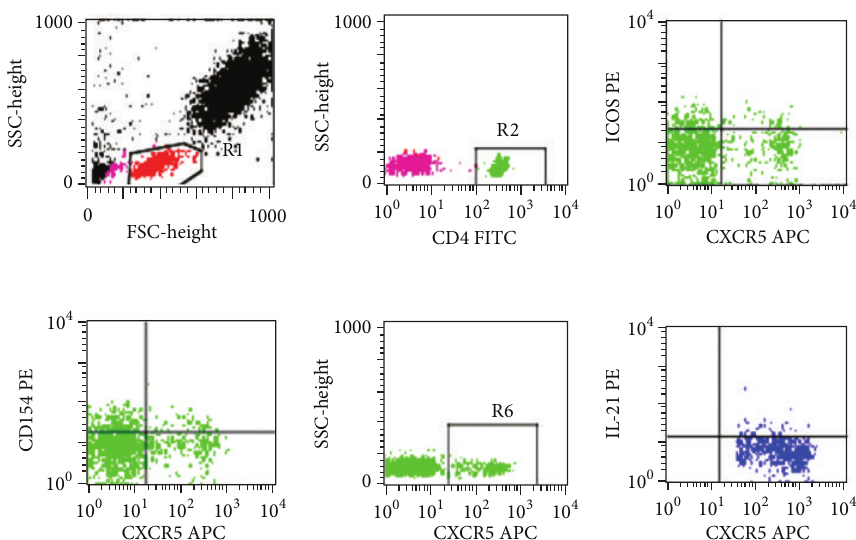
Figure2:IncreasedfrequencyoffollicularhelperT(Tfh)cellsinBMfromIRPpatients.RepresentativeflowcytometryplotsofCD4 + CXCR5 +